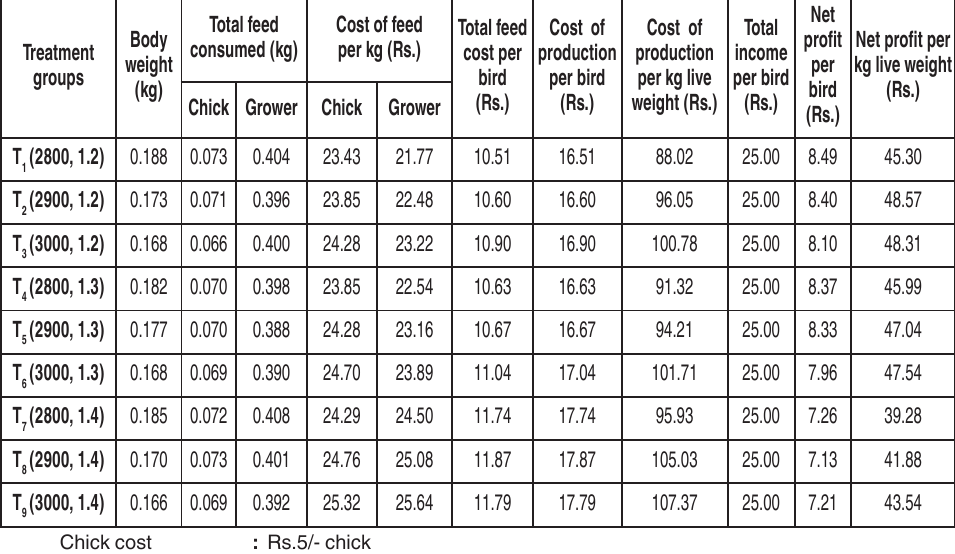
Chick cost : Rs.5/- chick Miscellaneous cost : Rs.1/- bird increasing energy (3000 kcal/kg) level in the diet had enhanced the production efficiency with minimum cost. The net profit per bird and net